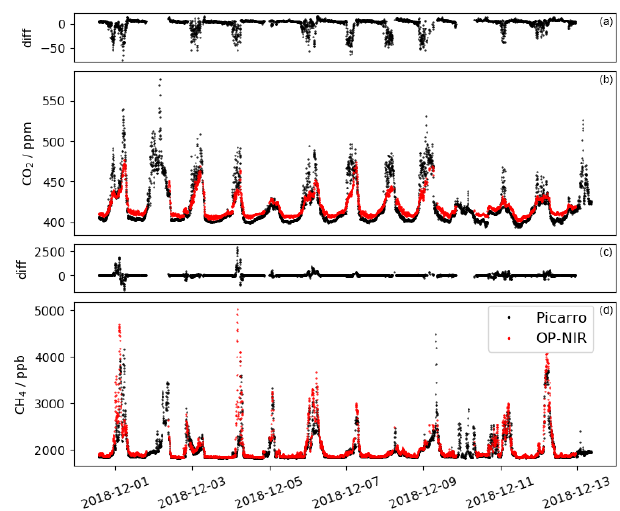
Figure 6. Time series of measured CO 2 (a, b) and CH 4 (c, d) from the OP-NIR (red) and in situ CRDS (black) measurements while the CRDS was co-located with the OP-NIR, from 1 to 13 Decem- ber 2018. For each gas, the upper panel (a, c) shows the difference between the OP-NIR and CRDS